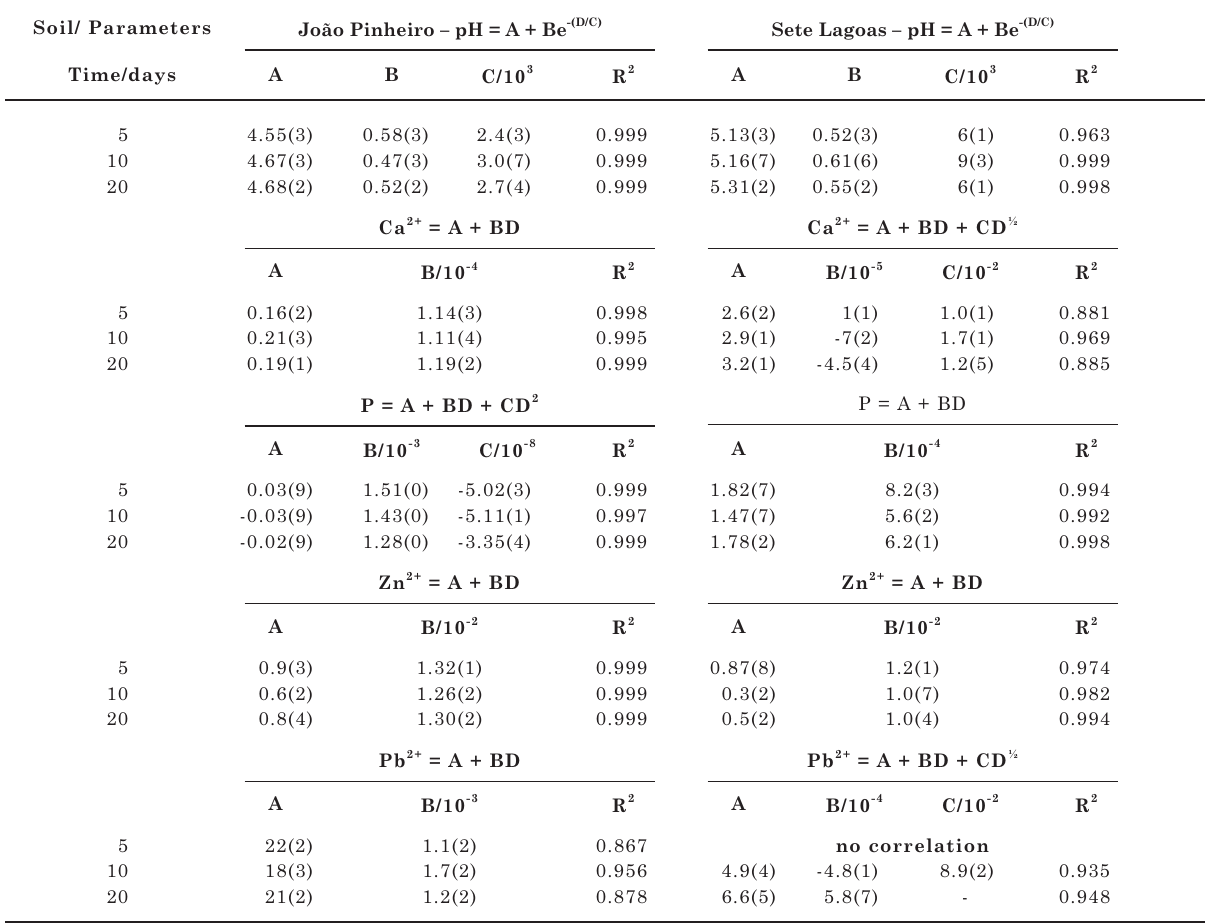
Sete Lagoas – pH = A + Be -(D/C)